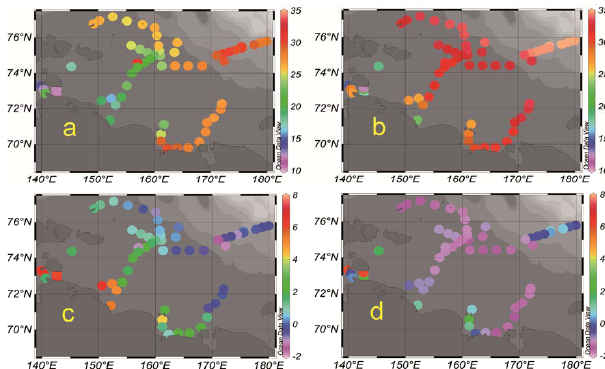
Fig. 3. The top panels show the salinity distribution in the surface water (a) and bottom water (b) while the lower panels show the temperature, ◦ C, distribution in the surface water (c) and bottom water (d)